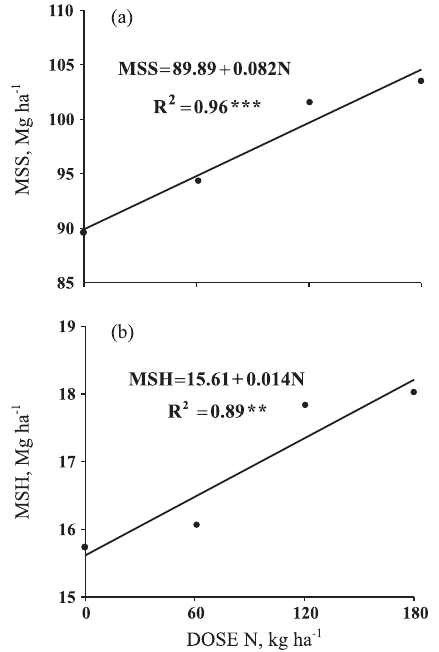
Figure 5. Stalk yield (MSS) (a) and sugar production per hectare (MSH) (b) in terms of doses of N- NH Cl (second ratoon of sugarcane). *** and ** 4 significant at 1 and 5